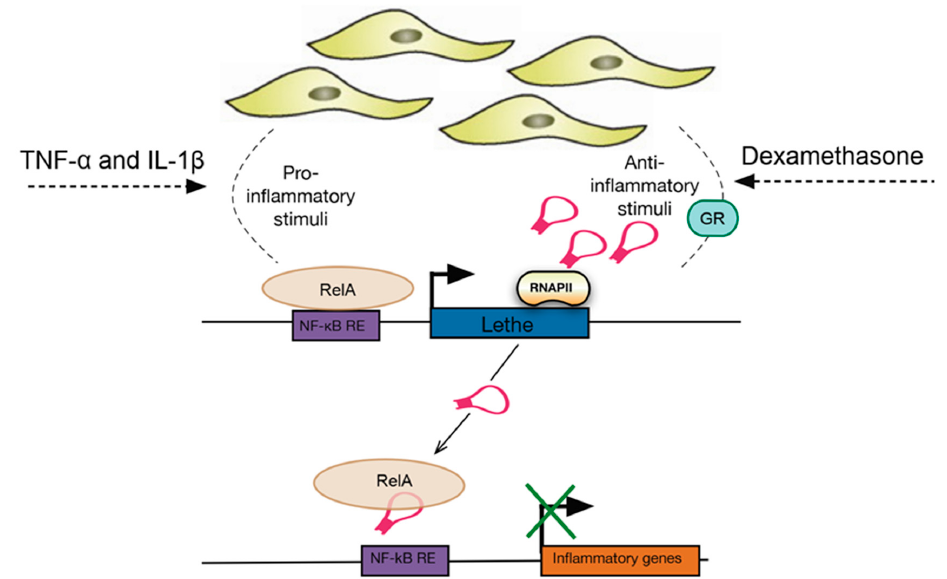
Figure 4. Lethe regulates gene expression upon exposure to TNF- α , IL-1 β and dexamethasone in fibroblasts. Activation of Lethe by either pro- or anti-inflammatory stimuli was found to inhibit expression of inflammatory genes by binding directly to RelA and preventing NF- κ B binding to DNA. Therefore, Lethe is suggested to act as a negative regulator of NF- κ B and the activation of the inflammatory response. GR, glucocorticoid receptor; NF- κ B RE, NF- κ B response element; RelA, transcription factor